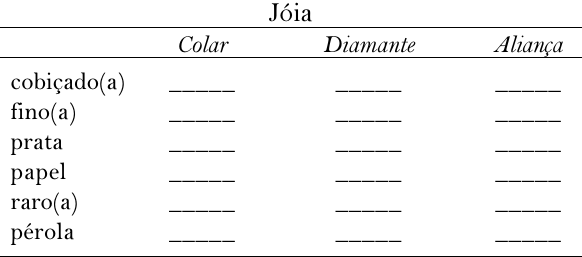
Figura 1 : Julgamentos de probabilidade dos